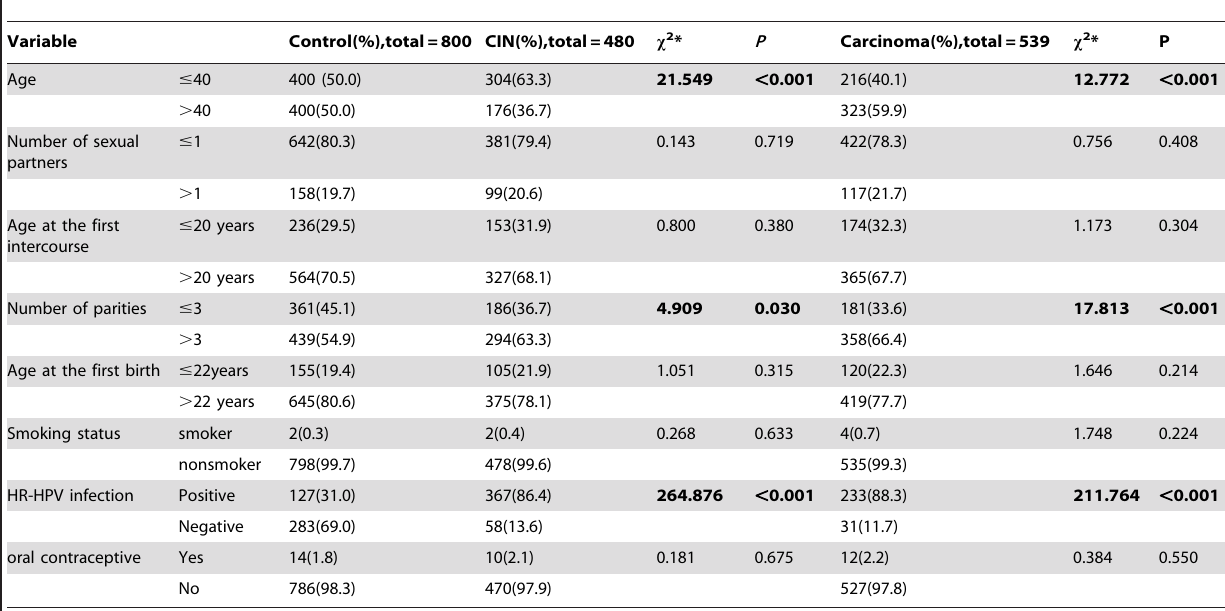
Table 1. Frequency distribution of selected characteristics by case control status.